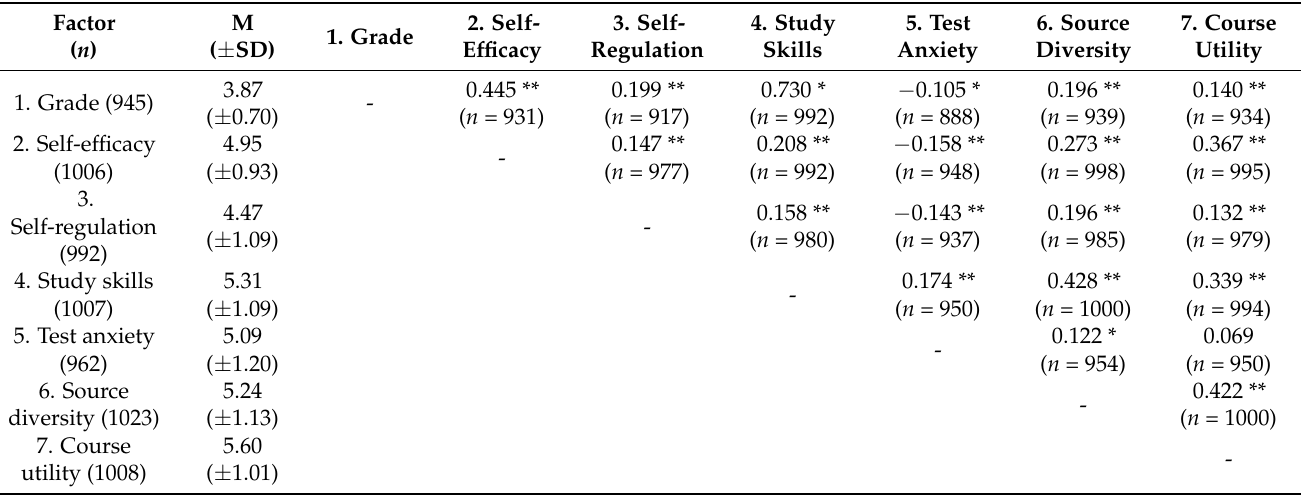
Table 8. Spearman’s correlation matrix shows relationships between factors and self-reported grade